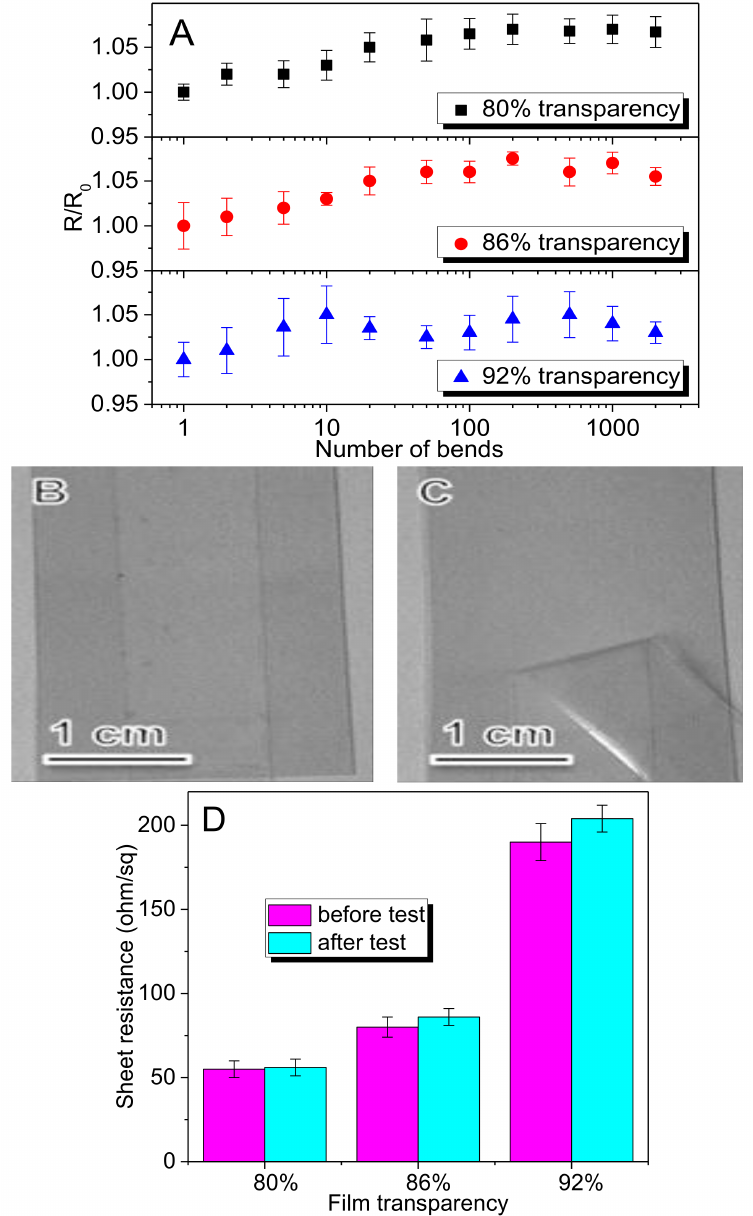
Figure 10. ( A ) Relative sheet resistance vs. benching cycles for rGO-SWNT films. R 0 is the electrical resistance of samples before bending, and R is the electrical resistance that changes with bending cycles. Error bars reflect standard deviation for five measurements; ( B , C ) Mechanical stability of rGO-SWNT/PET film: before and after the Scotch tape test; ( D ) Sheet resistance vs. transparency before and after Scotch tape peeling